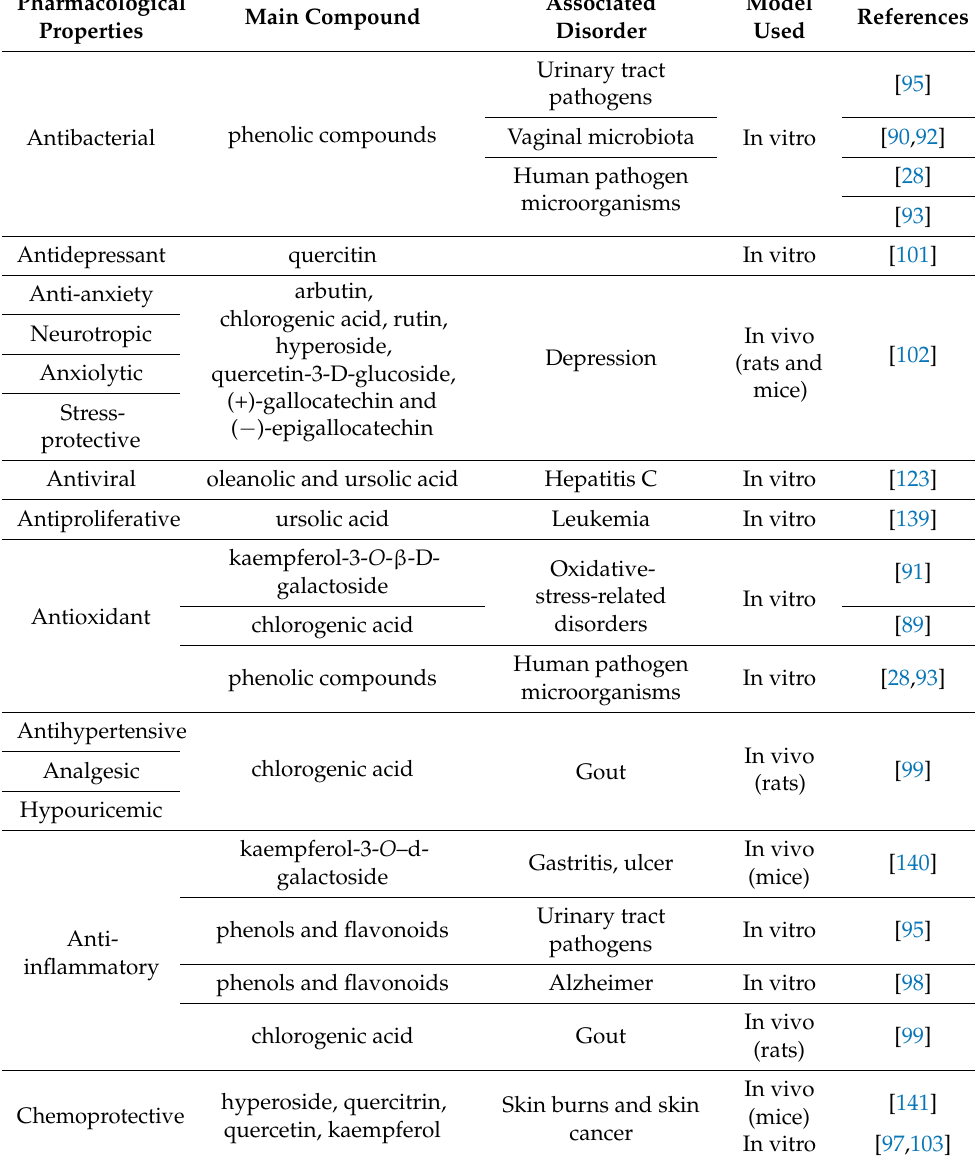
Table 3. Major pharmacological properties of the phytochemicals present in C. vulgaris and their associated